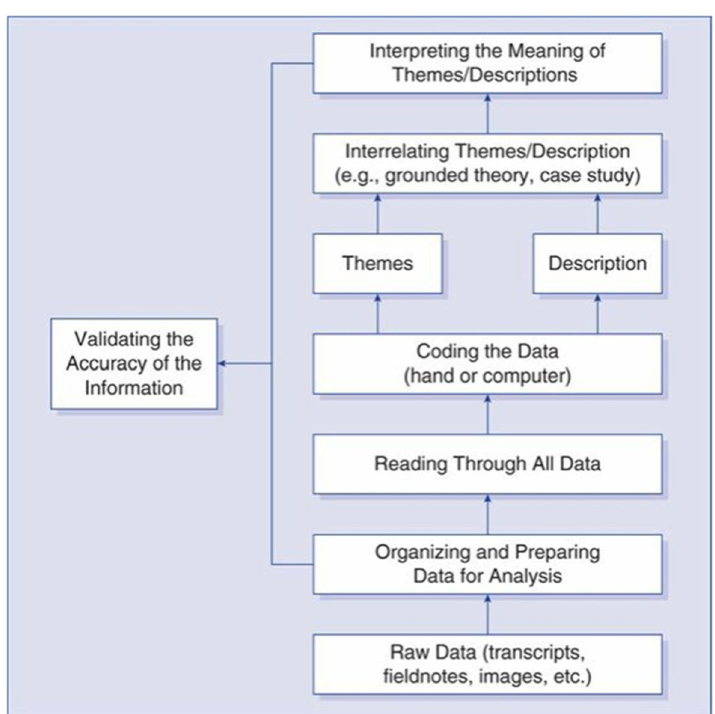
Fig. 3 The 6-step strategy for qualitative data analysis by Creswell and Creswell